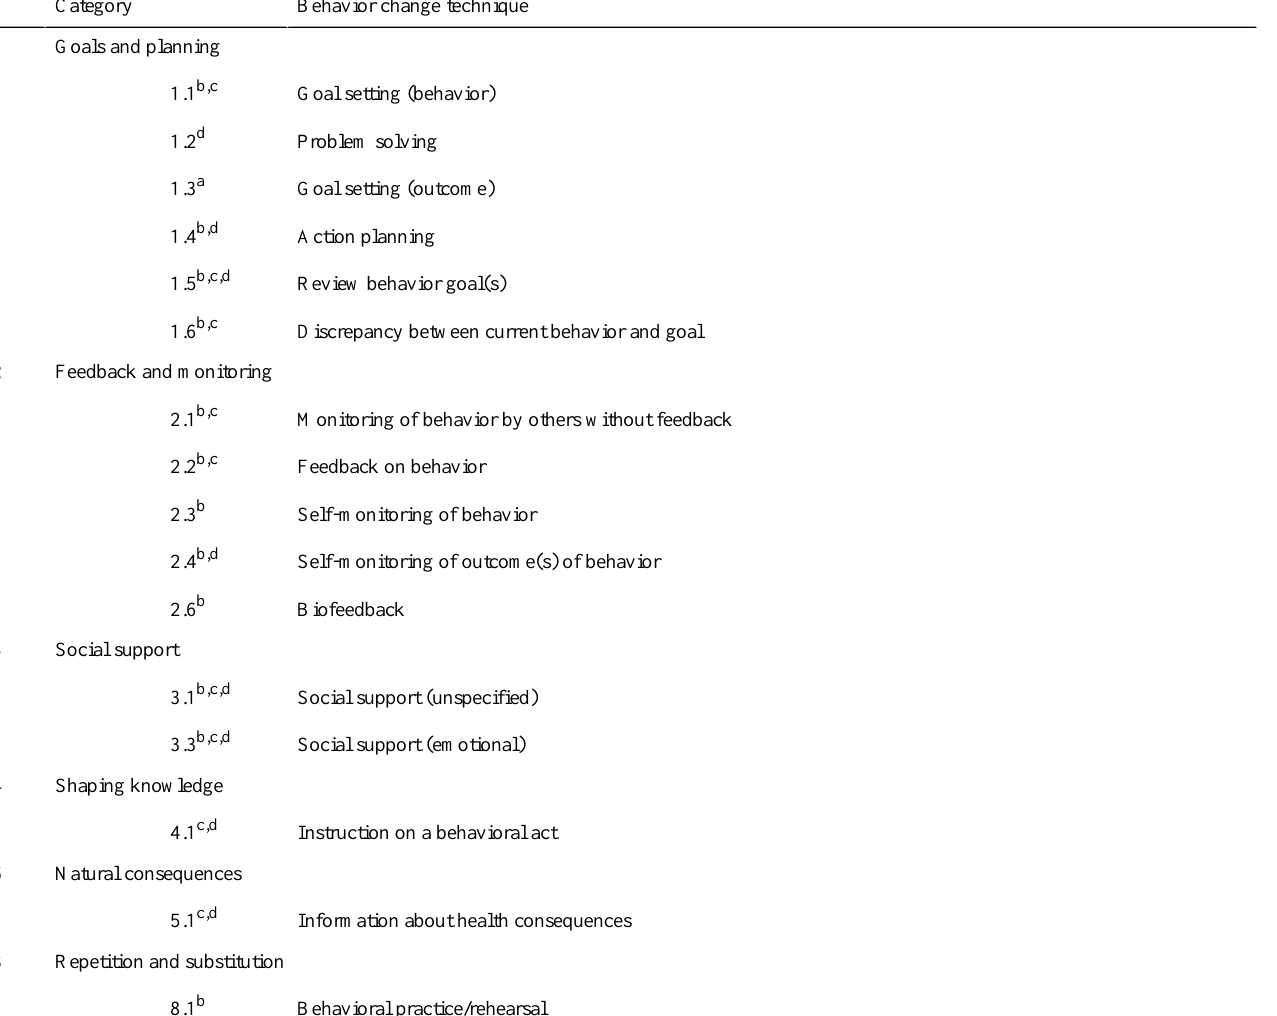
Table 1. REMOTE-CR behavior change techniques a . Behavior change